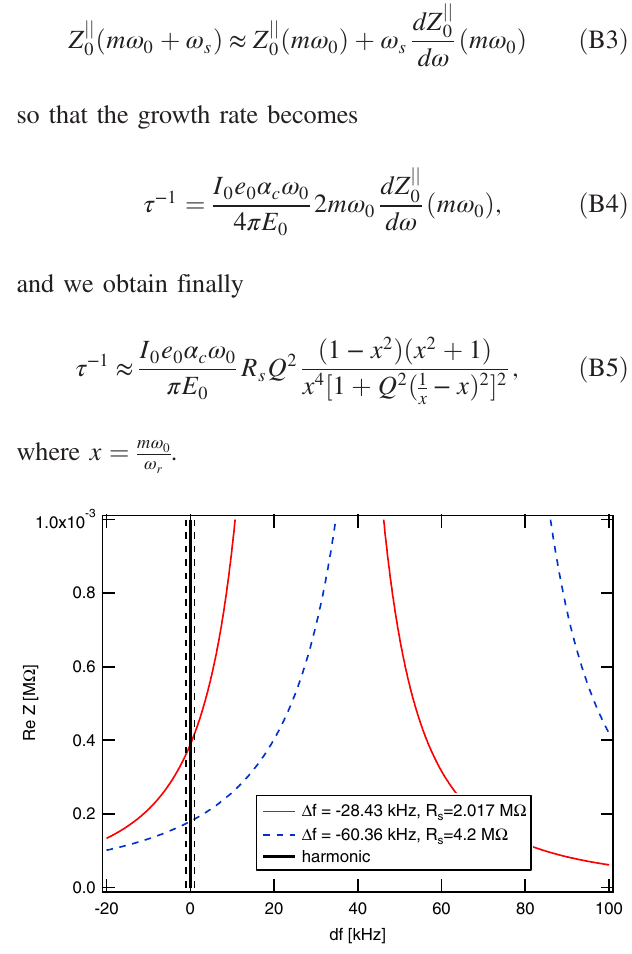
FIG. 10. Real part of harmonic cavity impedance for two different values of detuning and shunt impedances. The beam harmonic and synchrotron sidebands are indicated by the vertical black